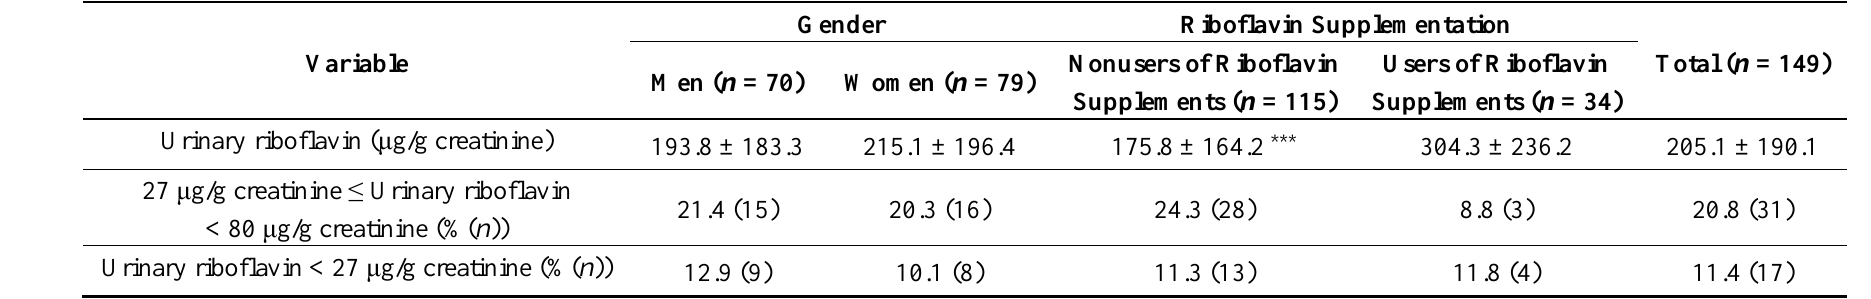
Table 3. Urinary riboflavin excretion of 149 Korean adults by gender and by riboflavin